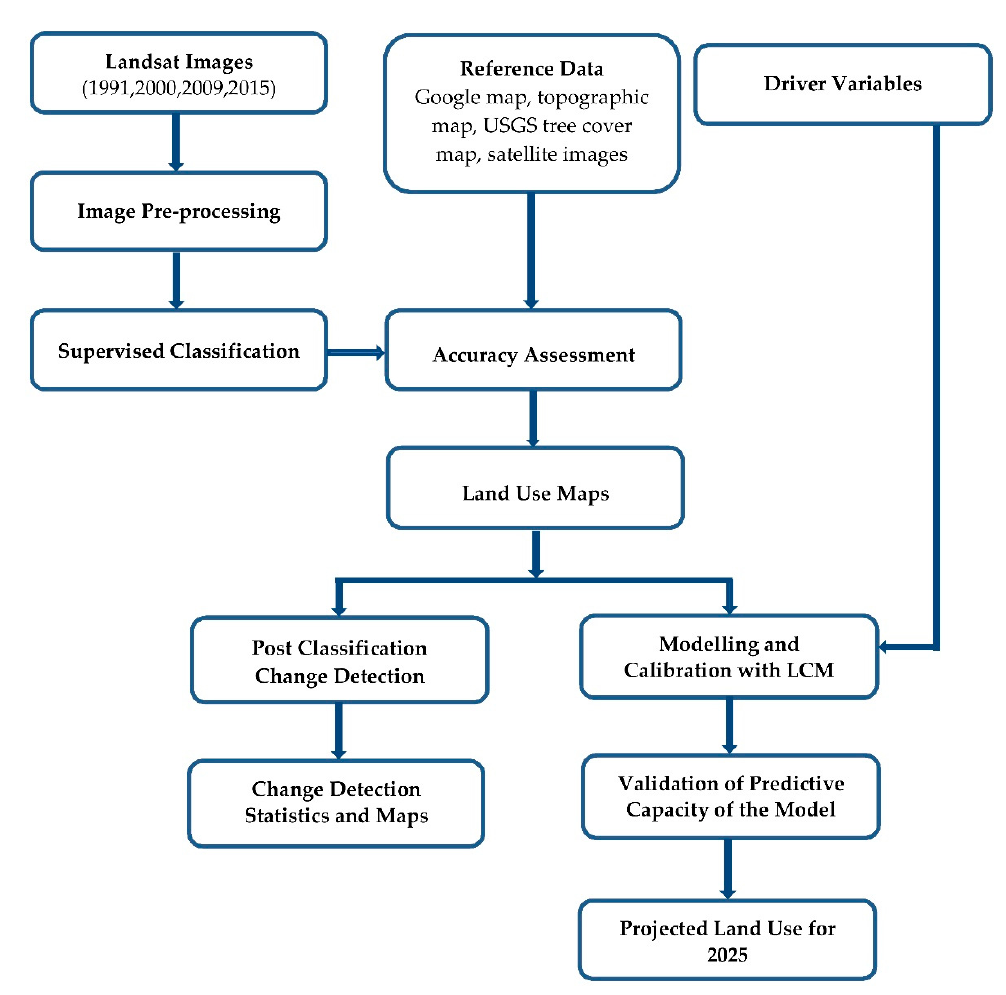
Figure 3. Flow chart of the research methodology.